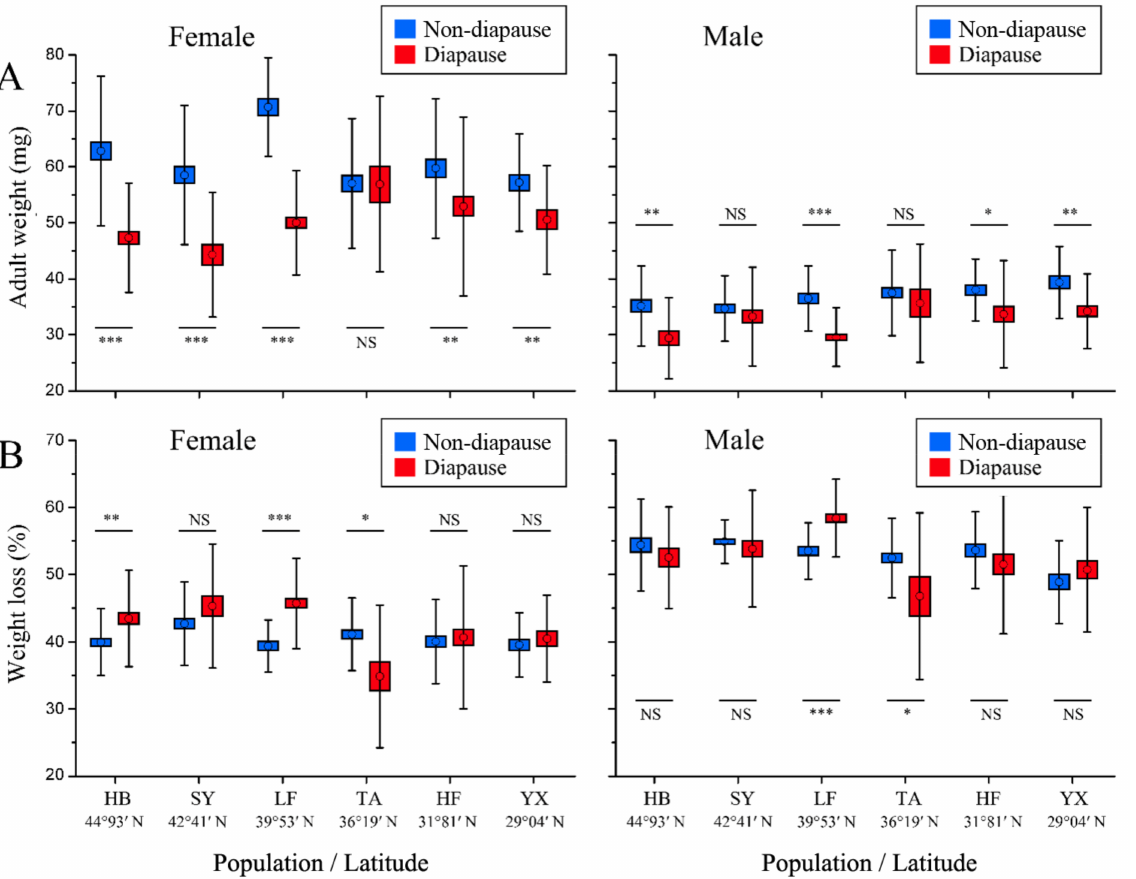
Figure 4. Adult weight ( A ) and weight loss ( B ) of non-diapausing and diapausing individuals in different geographical populations of Ostrinia furnacalis . The asterisk indicates a significant difference between non-diapausing and diapausing individuals in each subgraph (* p ≤ 0.05, ** p ≤ 0.01, *** p ≤ 0.001). NS = Nonsignificant. Error bars indicate